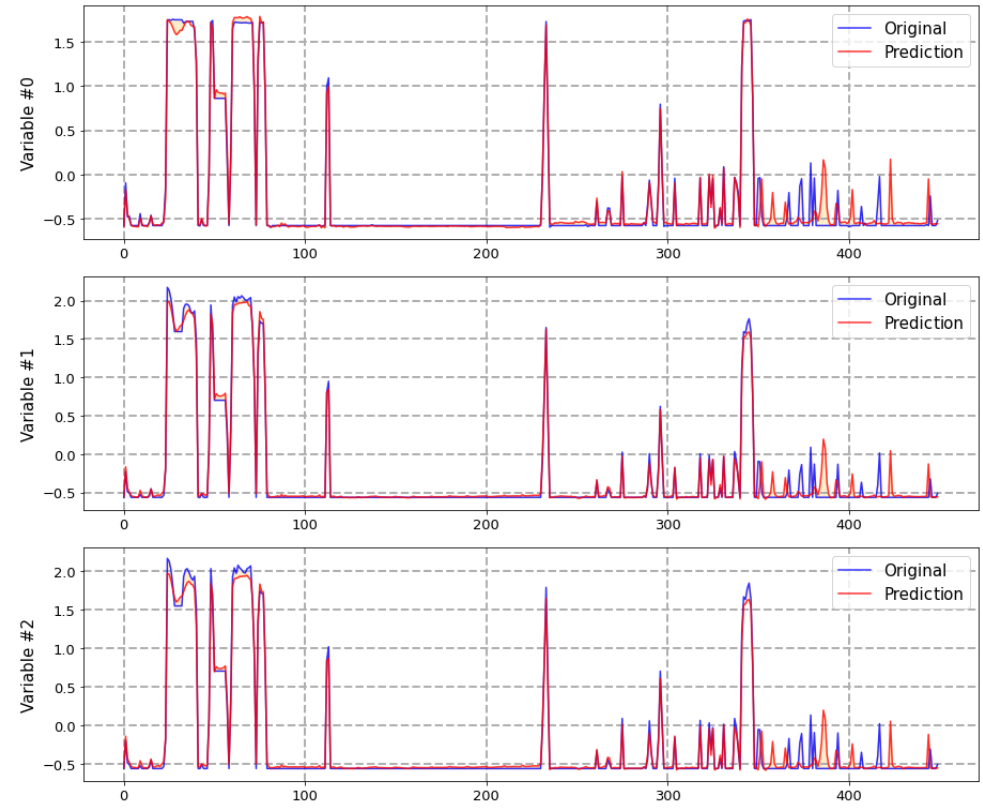
Figure 7. LSTM forecasting output (red) versus the real value (blue) for three variables of the diesel generator. Y -axis depicts the value of the variable. X -axis represents normalized data coming from the